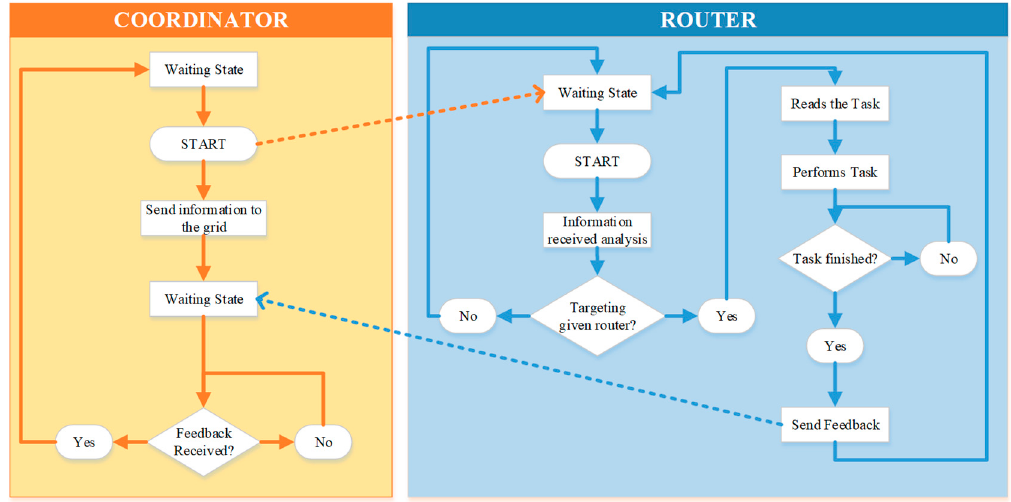
Figure 4. Flowchart of the communication system.